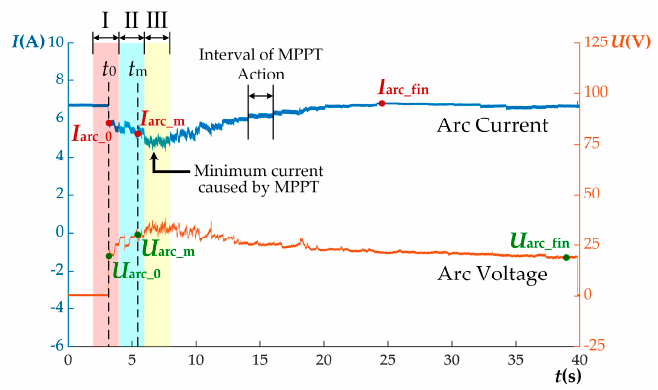
Figure 6. Minimum arc current and maximum arc voltage caused by MPPT.